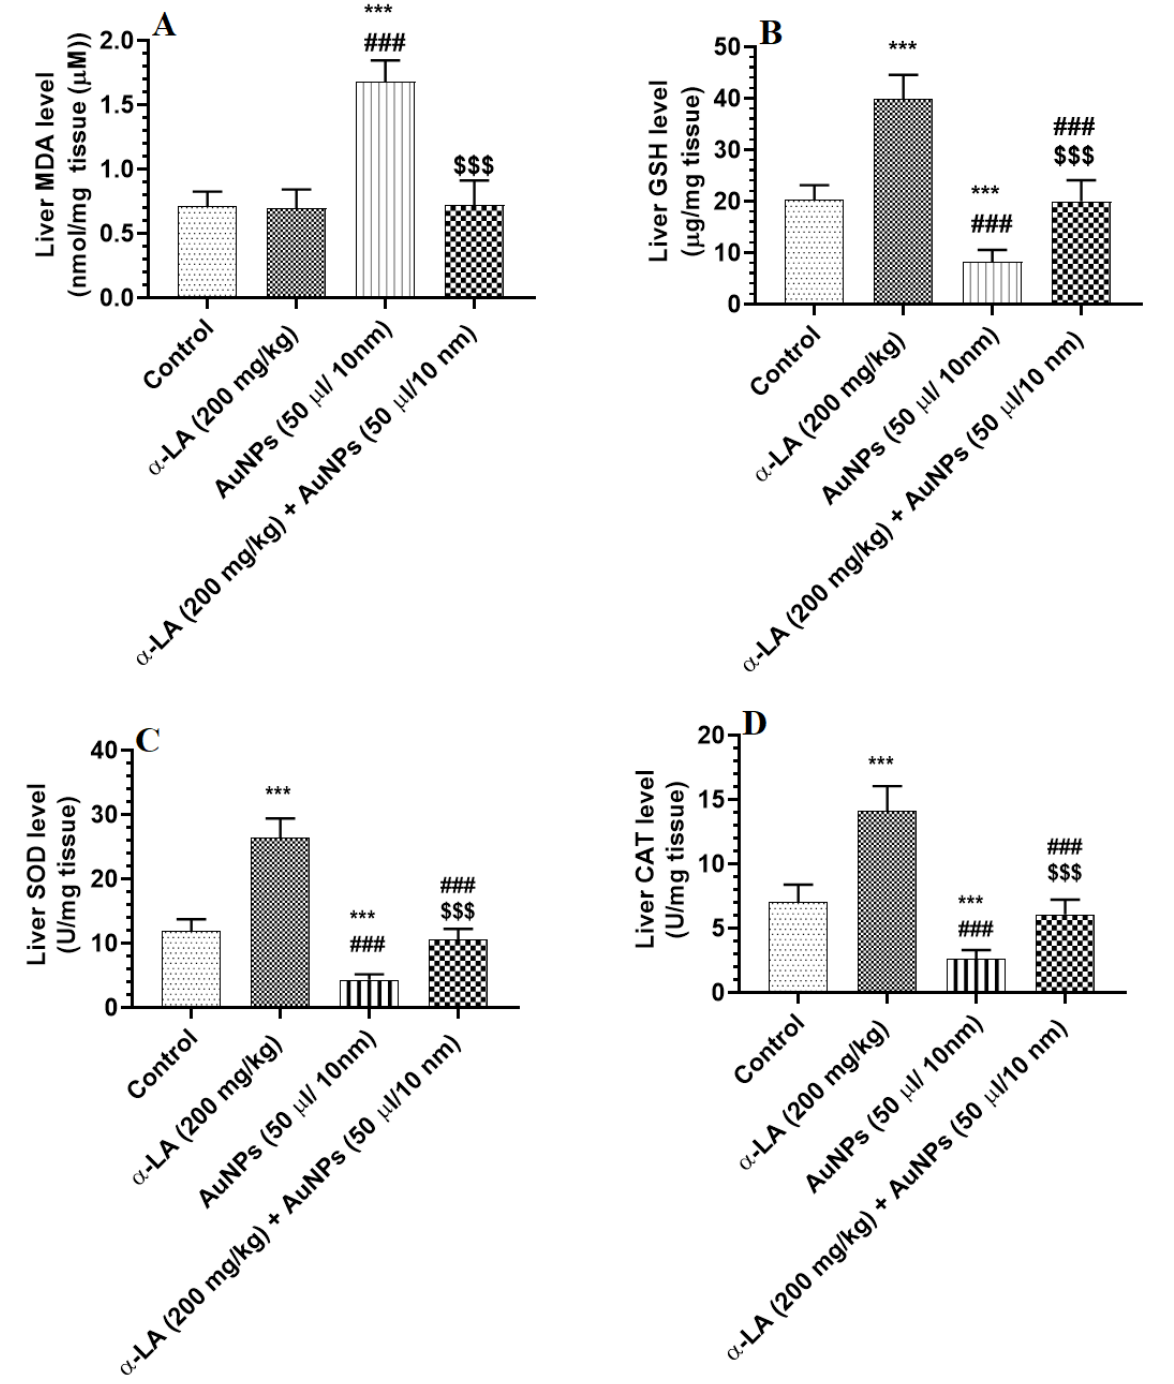
Figure 3. α -lipoic acid (LA) suppresses lipid peroxidation in the livers of gold nanoparticles (AUNPs)-treated rats but stimulates endogenous antioxidants in the livers of the control and AUNPs-treated rats. ( A ): malondialdehyde (MDA) (lipid peroxides), ( B ): total glutathione reduced (GSH), ( C ): superoxide dismutase (SOD), and ( D ): catalase (CAT). Measurements of MDA were performed by an assay kit, and the measurements of all other antioxidants were performed by ELISA. Data were given as means ± SD (n = 8/group). p < 0.05. ***: vs. control at p < 0.0001; ###: vs. α -LA at p < 0.0001; and $$$: vs. AuNPs at p < 0.0001.